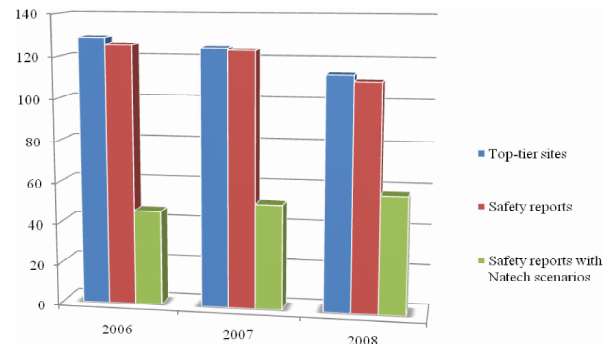
Fig. 7. State of emergency plans testing. Figure 7. State of emergency plans testing 3